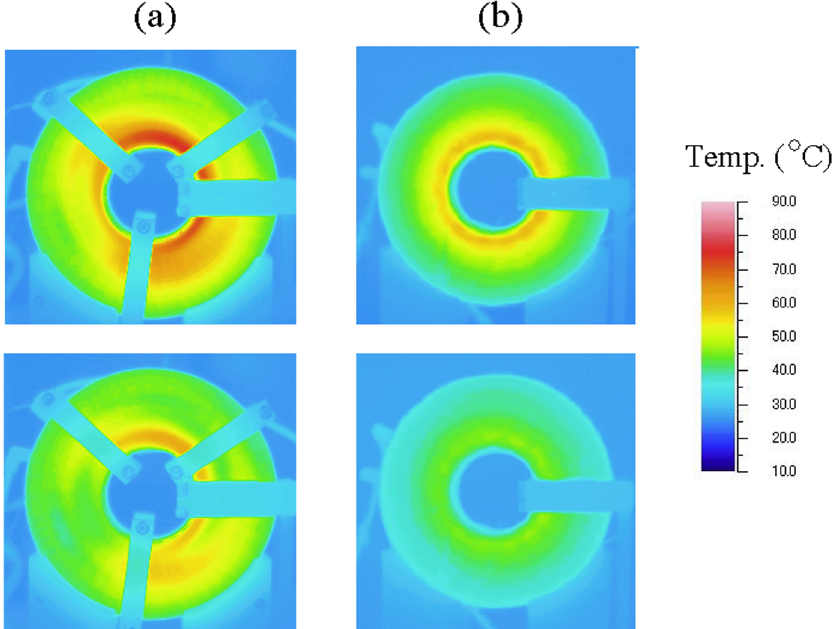
FIG. 8. (Color) The surface temperature distribution for the polyimide-resin-adhered core as an example at the feeding power density of 0 : 2 W = cm 3 . (a) Irregularly distributed hot spots were observed at first, indicating a loose adhering process. (b) A nice radial temperature distribution is seen after improving the adhering process. Top and bottom figures correspond to the temperature distributions after 15 min of power feed and 2 min of power cut, respectively. Disk-shaped area corresponds to the surface of FINEMET core. Three strip shape objects of (a) and a thick square object seen at the right side of the figures are the support materials and a power feeding loop,